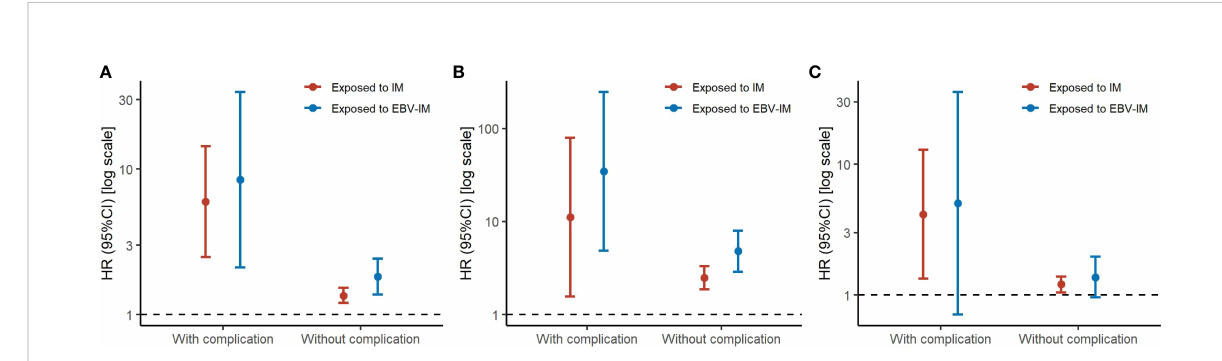
FIGURE 2 Risks of Subtypes of Malignancy According to Infectious Mononucleosis (IM) with Different Disease Durations. Graph shows adjusted hazard ratios (HRs) with error bars representing 95% con fi dence interval (CIs) for total malignancy (A) , hematologic malignancy (B) , and other malignancy excluding hematologic malignancy (C) . The analyses were adjusted for sex, maternal age at delivery, parity, maternal education, maternal residence, parental malignancy history.